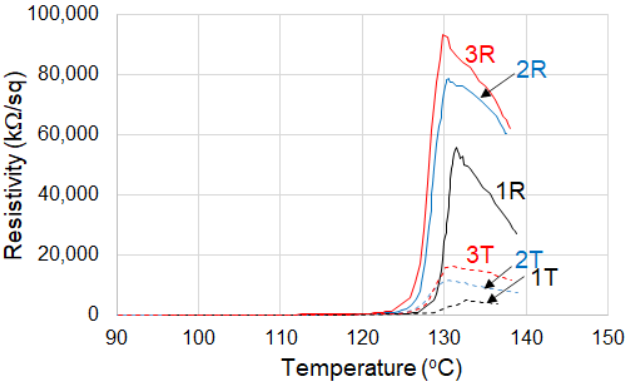
Figure 9. Resistivity vs. temperature for (CB + Gr)/(LLD + HD) samples on repeated temperature cycles, heating portions: 1T, 2T, 3T — thermoplastic (D = 0 kGy) cycles 1, 2, 3, respectively; 1R, 2R, 3R — crosslinked (D = 150 kGy), cycles 1, 2 and 3, respectively. Table 3. Kinetic data of resistivity increase upon the heating of (CB + Gr)/(LLD + HD) composites.